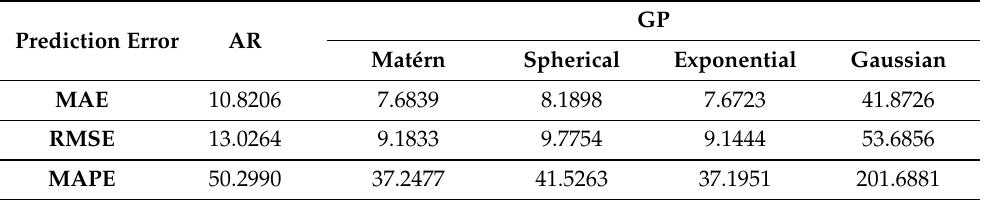
Table 1. Spatial prediction error of GP and AR models.